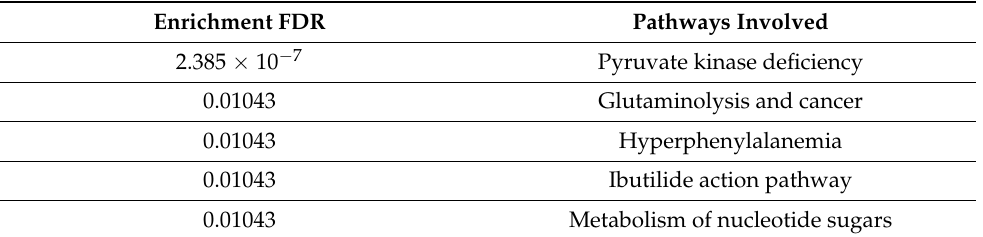
Table 7. Principal pathways overexpressed in CGGA males compared with the TCGA astrocytoma group in correlation with the A 2A R expression obtained through INOH